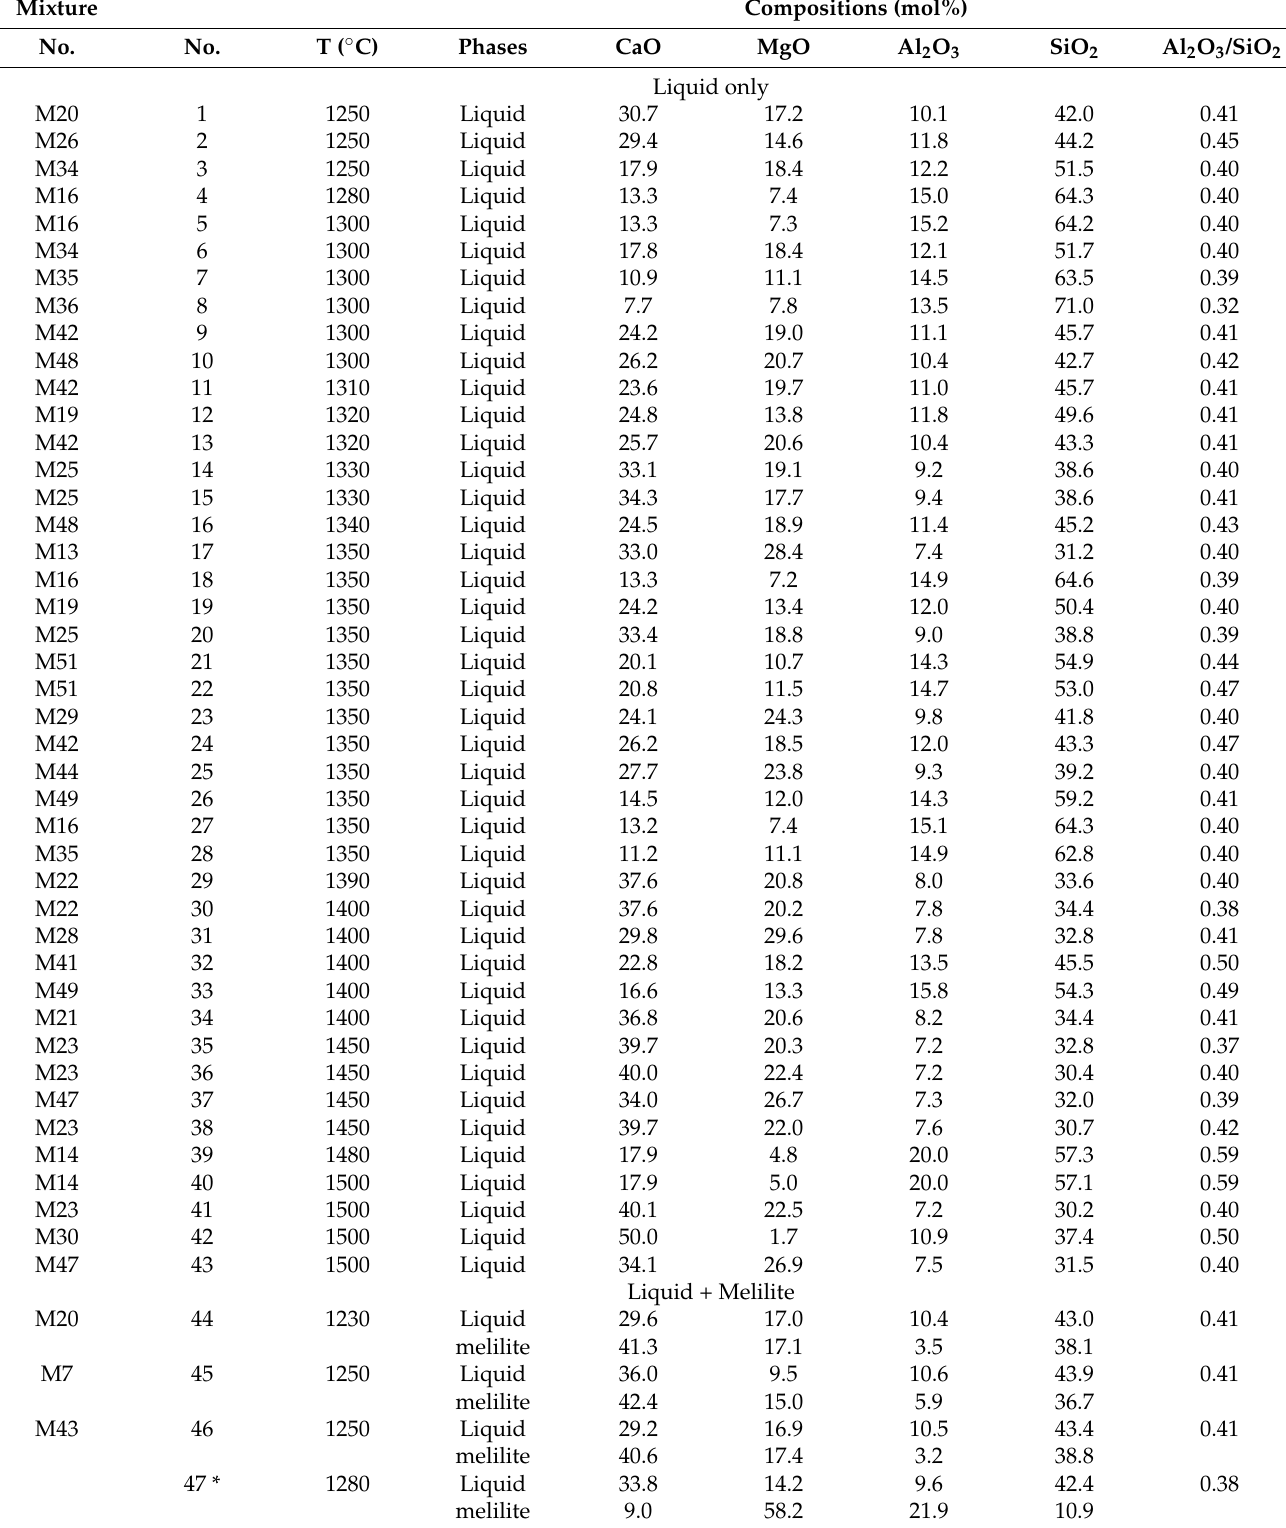
Table A3. Experimental Results in the System CaO-MgO-Al 2 O 3 -SiO 2 system with Al 2 O 3 /SiO 2 weight ratio of